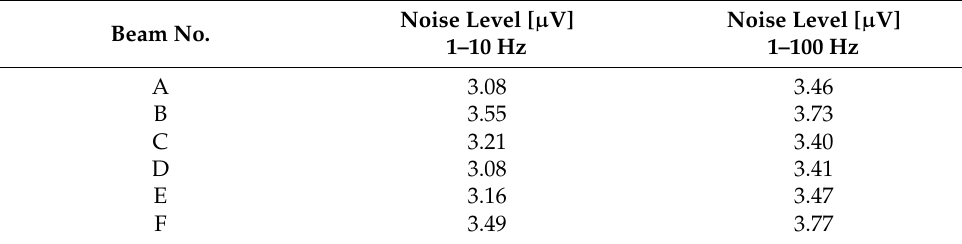
Table 4. Noise levels of each element. Beam No.